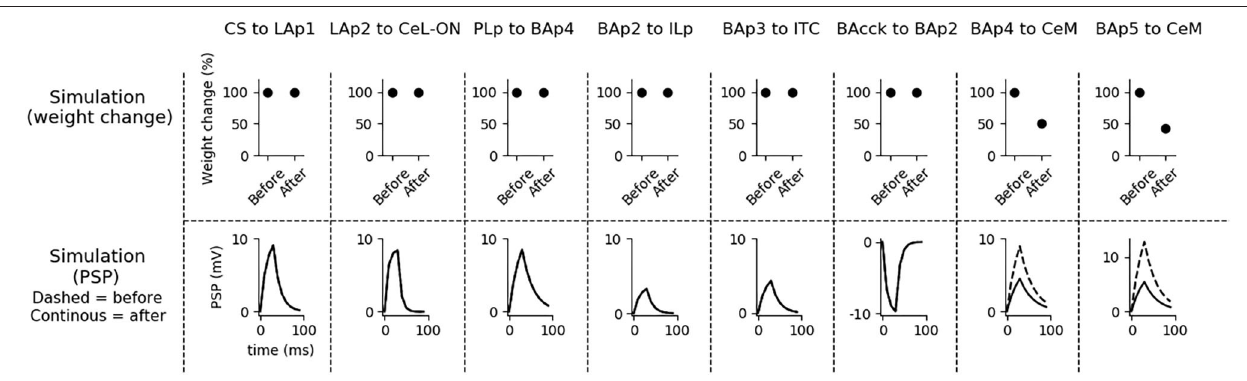
FIGURE 11 | Effects on synaptic plasticity of DSI blockade in BA during extinction. If DSI is inactivated during extinction, plasticity is severely compromised at the synapses PLp-BAp4, BAp2-ILp, BAp3-ITC, and BAcck-BAp2 (compare these results with Figure 4